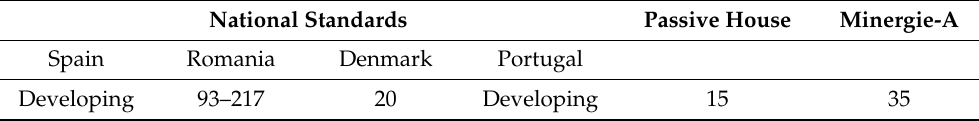
Table 11. Primary consumption coefficient (kWh/m 2 a) comparative.